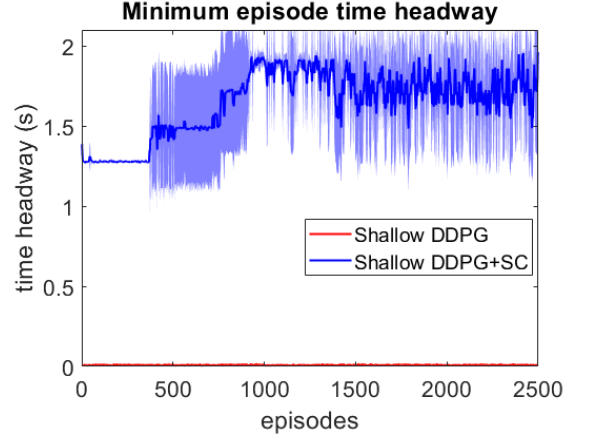
Figure 8. Comparison of the shallow vehicle following agents’ minimum TH per episode over adversarial training runs with lead vehicle velocity limits v lead ∈ [ 17,40 ] m/s. Averaged over 3 runs, with standard deviation shown in shaded colour.